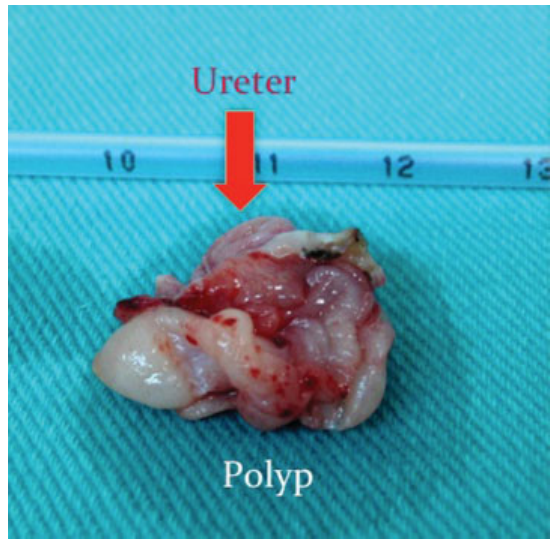
Fig. 5 Surgical margins of